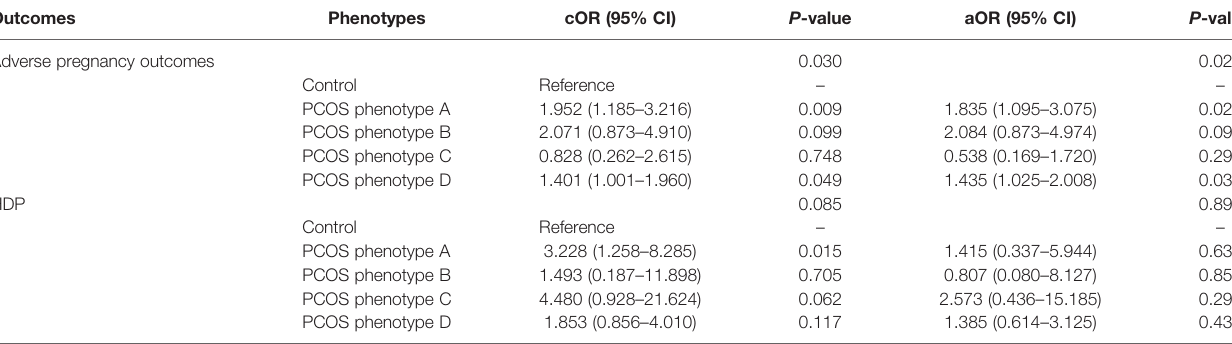
TABLE 4 | Logistic regression analysis of maternal and perinatal outcomes.